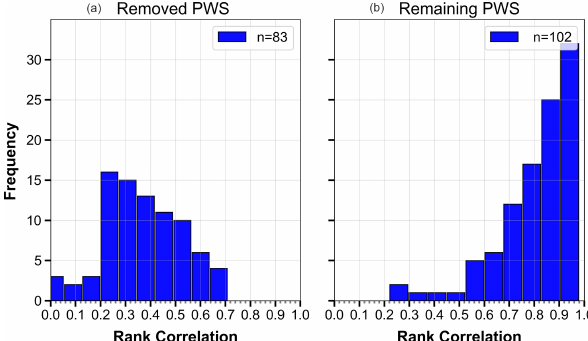
Figure 8. Example of transformation and bias correction of precip- itation amounts at a secondary